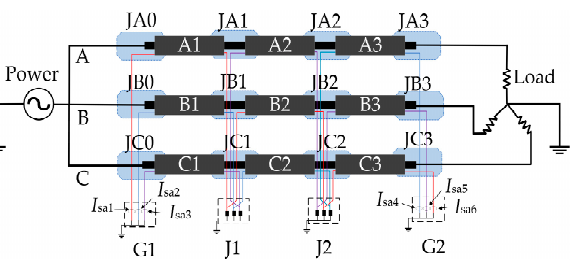
Figure 9. Schematic diagram of a power system with a cross-connected main section.